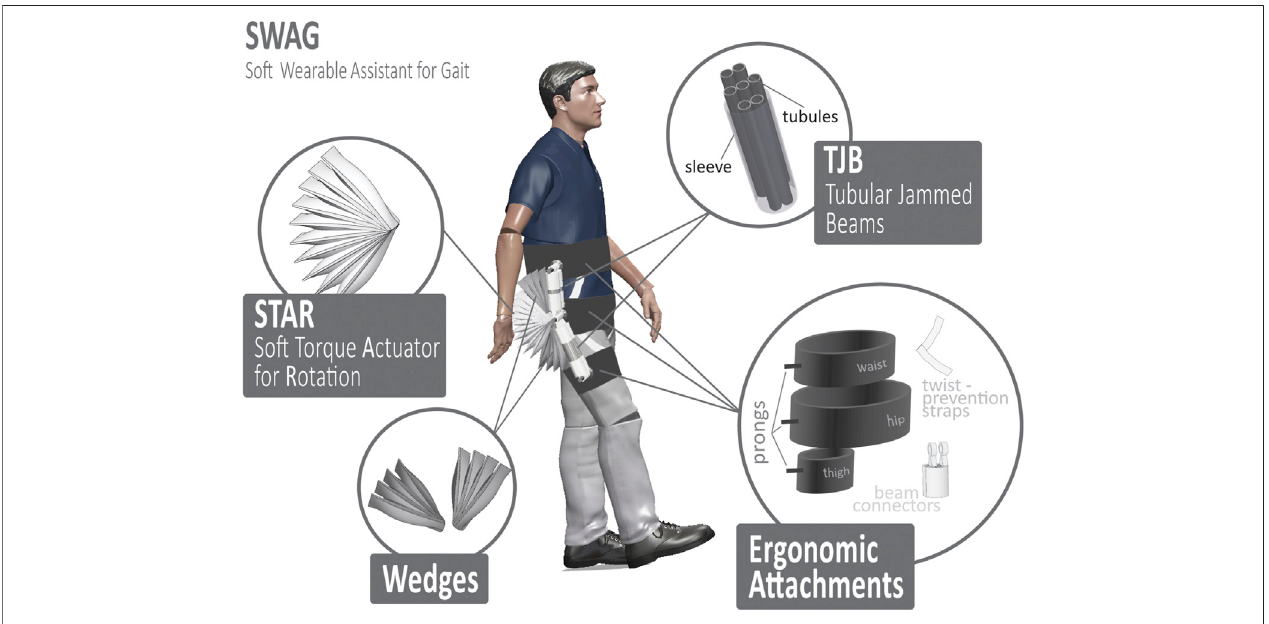
FIGURE 1 | Overview of soft wearable assistant for gait